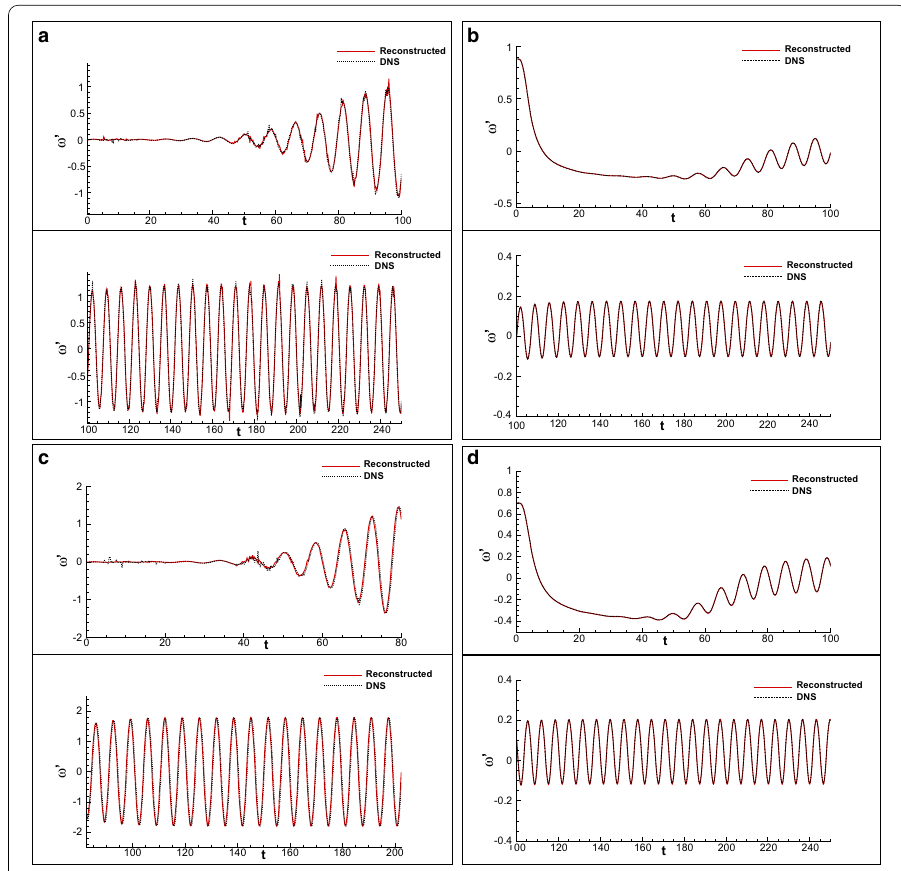
Fig. 11 Reconstructed disturbance vorticity with time-scaling interpolation for a Re = 70 using Re = 68, 72, and 76 at (0 . 504 , 0 . 0), b at (1 . 104 , 0 . 0) and c Re = 83 using Re = 78, 80, 86 and 90 at (0 . 504 , 0 . 0) and d at (1 . 104 , 0 . 0). Within each subfigure, the top frame is for comparison at early times, while the bottom frame shows comparison at later